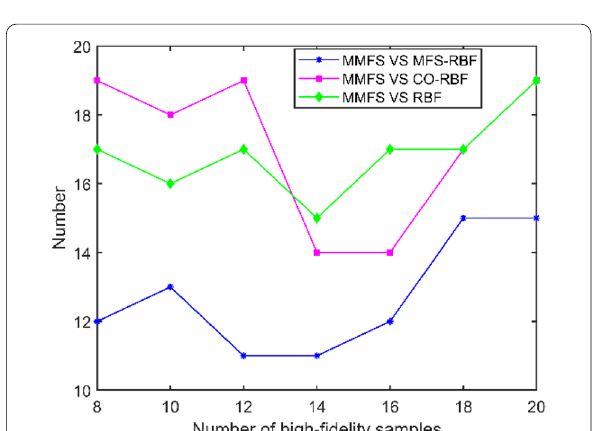
Figure 8 Number of MMFS better than other methods of 20 DoEs of Beale